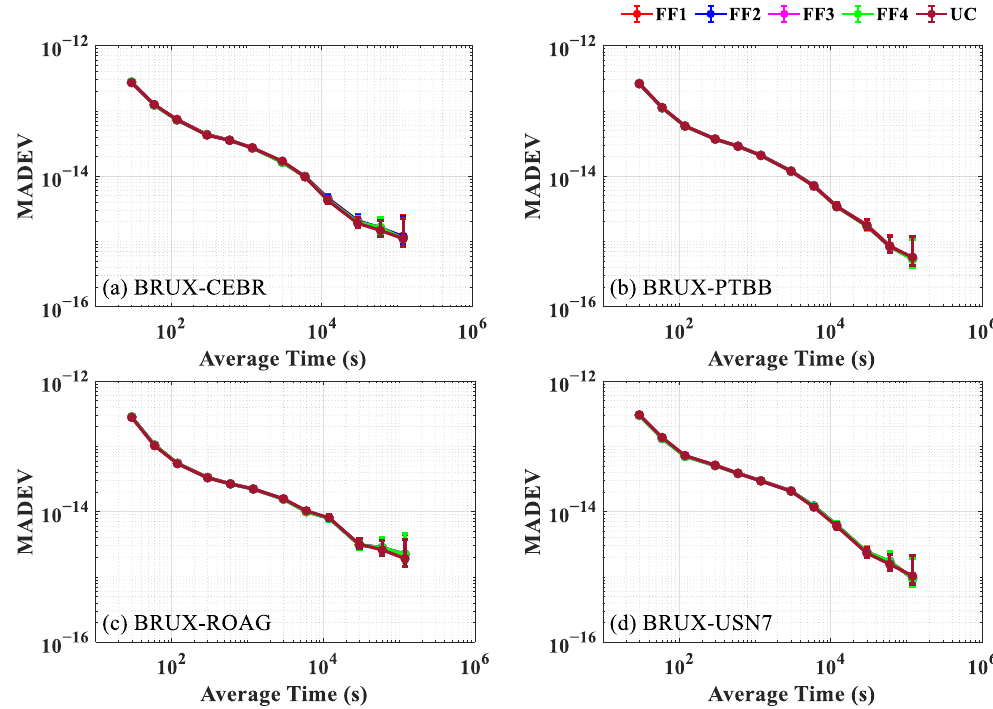
Figure 10. MADEV at four time-frequency links for the FF1, FF2, FF3, FF4 and UC PPP solutions on DOYs 190 to 196 in 2020. ( a ) BRUX-CEBR time-frequency link; ( b ) BRUX-PTBB time-frequency link; ( c ) BRUX-ROAG time-frequency link; and ( d ) BRUX-USN7 time-frequency link.